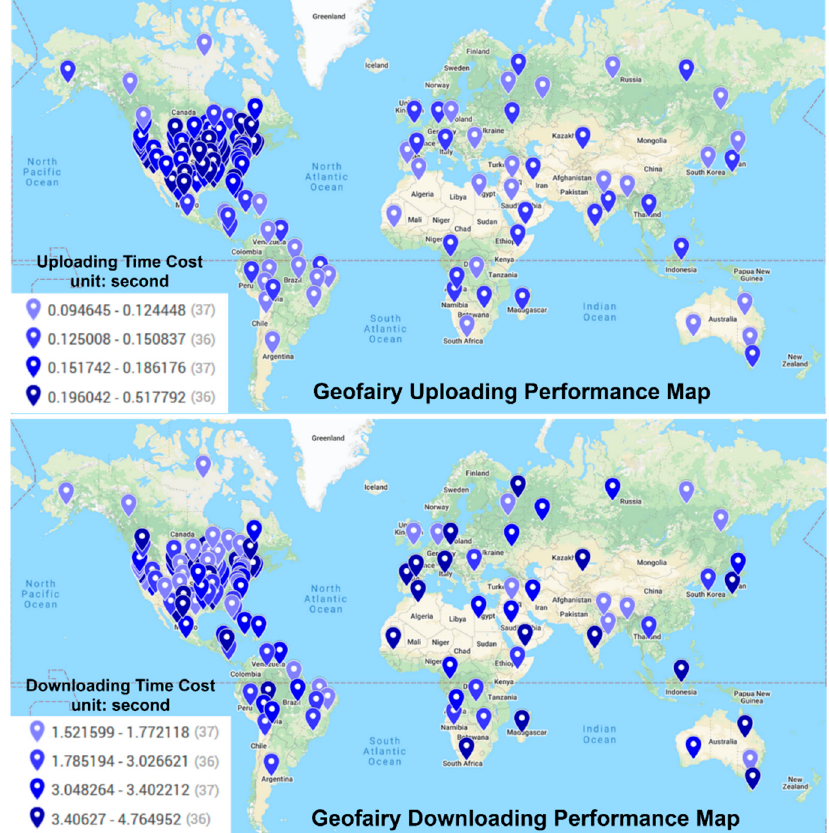
Figure 7. GeoFairy2 Global Performance Maps.